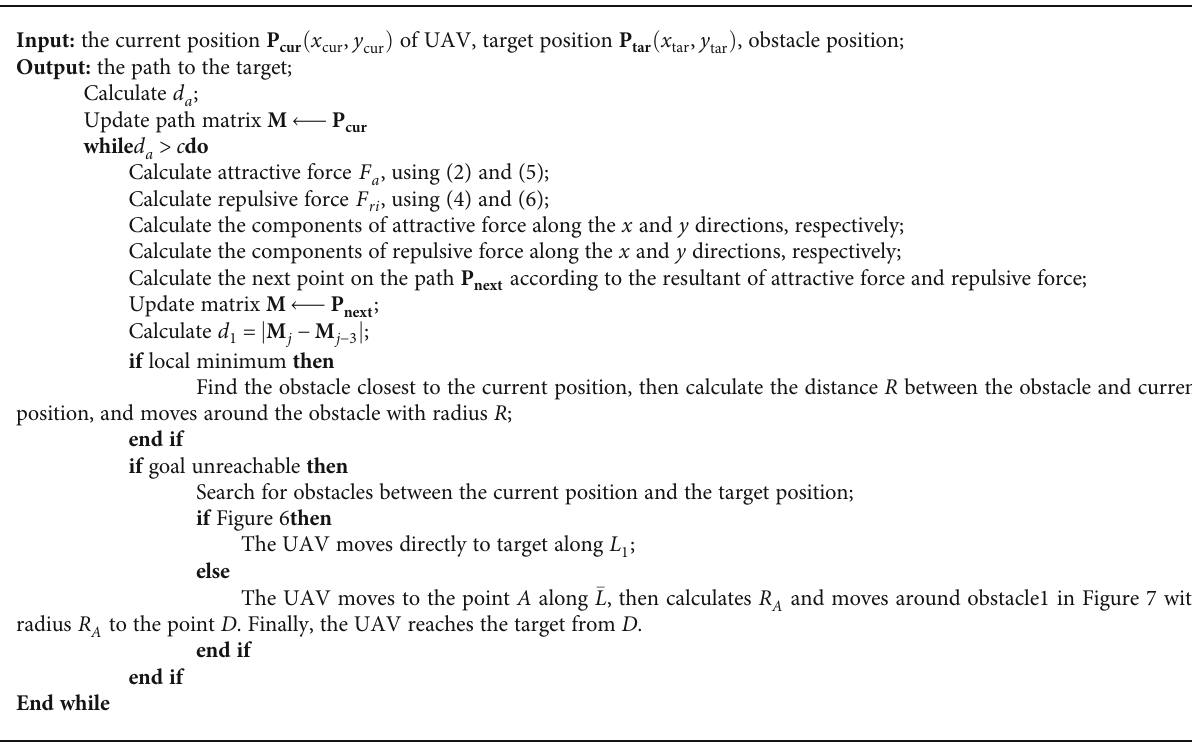
Algorithm 2: A novel APF algorithm based on parallel search for path planning of